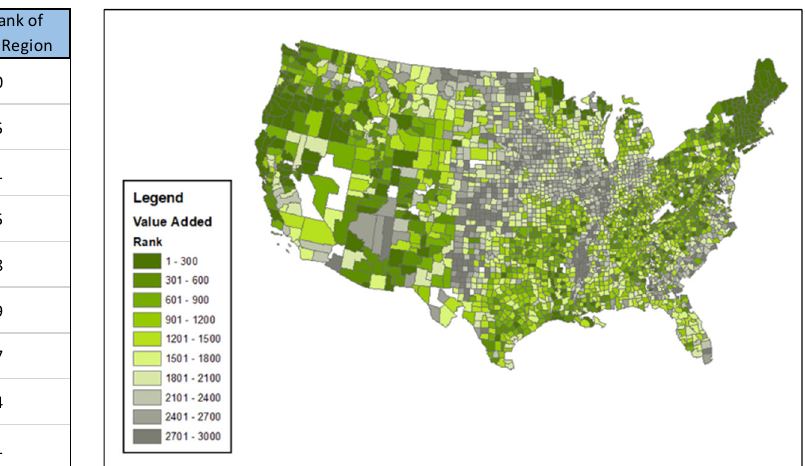
Table 6. Region Ranking: Value Added, 2012 Map 5. Value Added Rank, 2012